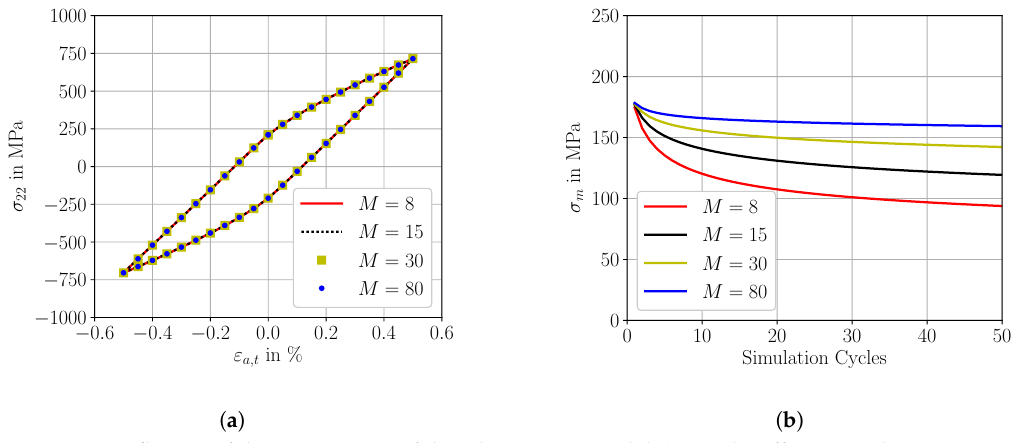
Figure 12. Influence of the exponent M of the Ohno–Wang model, ( a ) on the effective cyclic properties at zero mean stress; ( b ) on the mean stress relaxation behavior at ε a , t = 0.50% at R ε =